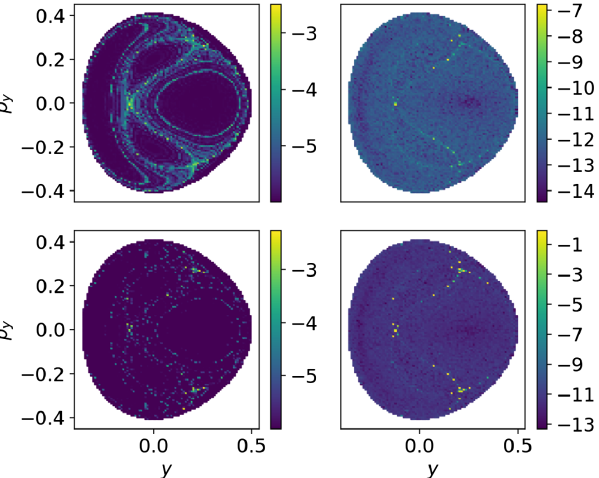
FIG. 26. Dynamic aperture of x ¼ 0 and E ¼ 1 = 12 surface projected on y - p plane. The left and right columns are FMA y and REM respectively. The top and bottom rows are T ¼ 512 and T ¼ 2048 respectively. The numerical integration step size was dt ¼ 10 − 3 .